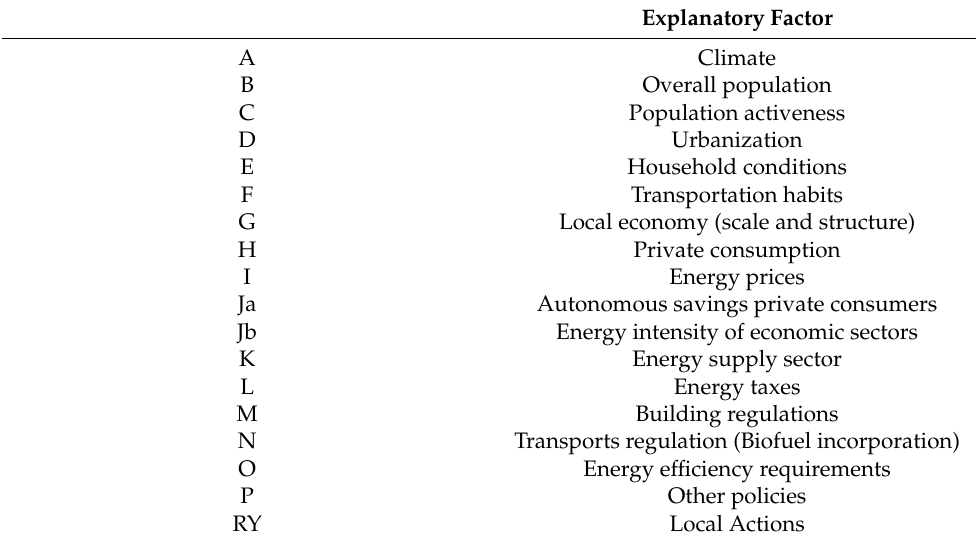
Table 1. List of factors of change considered by the disaggregation model for the decomposition of the observed changes in local greenhouse gas (GHG) emissions.